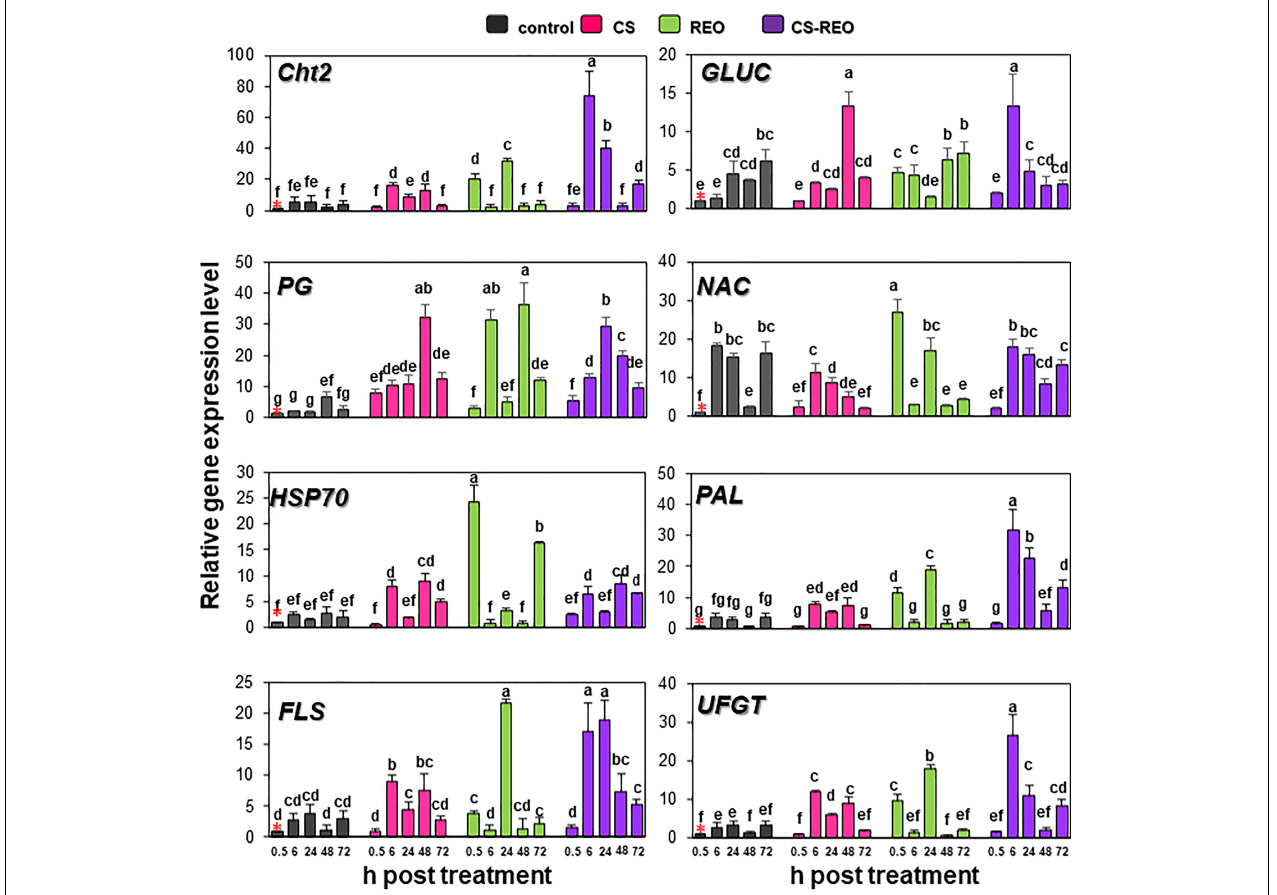
FIGURE 4 | Quantification of relative gene expression of the remaining eight of the defense genes examined (as indicated; refer to Table 1 ) in papaya fruit following treatments with water (control), 0.5% CS, 0.5% REO, and their combination (CS-REO). Each experimental replicate represents three technical replicates ( n = 6). Gene expression given was relative to control at 0.5 h posttreatment, also indicated with a red asterisk, according to the 2 − (cid:49)(cid:49) Ct method (Livak and Schmittgen, 2001). Data are the means ± SD. Columns with different letters are significantly different ( P ≤ 0.05; Duncan’s multiple range